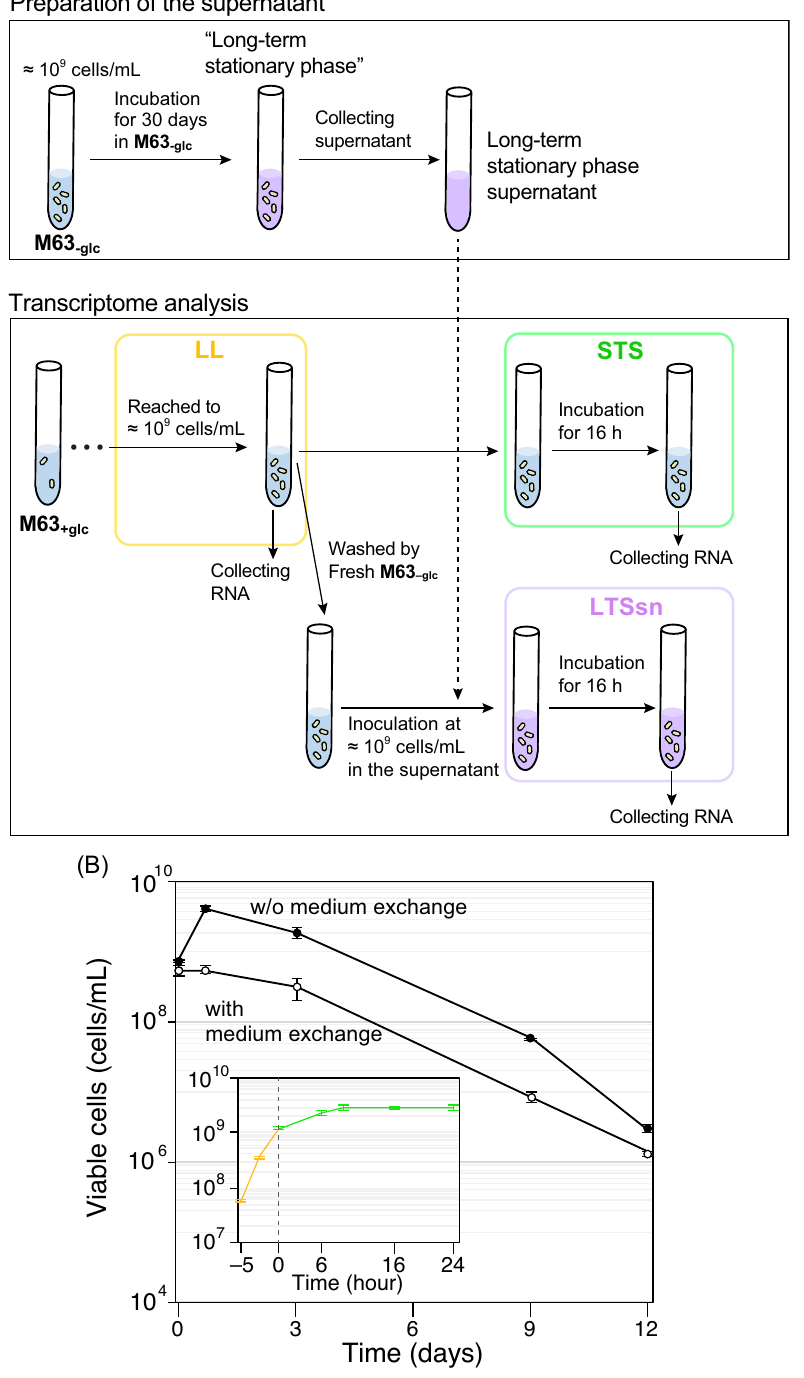
Figure 1. Experimental design for the transcriptome analysis. ( A ) The design for collecting RNA and preparing the supernatant. For the preparation of the supernatant from the long-term stationary phase culture, E. coli cells were grown in M63 –glc for 30 days, and the supernatant was collected (see “Methods”). For collecting RNA samples, we first cultured E. coli cells in M63 +glc for 20 h and collected the samples for RNA extraction after the population reached to 10 9 cells/mL (labeled as LL). Then, this culture was immediately divided into two aliquots. One divided aliquot from the LL phase culture was further incubated in the same condition without medium exchange, which eventually entered short-term stationary phase. We collected the samples, labeled as STS, 16 h after inoculation. To prepare the LTSsn samples, we washed the other aliquot with fresh M63 –glc and inoculated it into the long-term stationary phase supernatant. We collected the samples 16 h after medium exchange. ( B ) Temporal changes in the number of viable cells with or without medium exchange (white and black circles, respectively). An inset shows the growth curve of the cells from the LL phase (yellow line) to the short-term stationary phase (green line). The sample preparation was performed according to the procedure explained in panel ( A ). The time point of division into two aliquots was set at 0 h in the figure. The number of viable cells was estimated by the CFUs. Error bars indicate standard deviations of biological